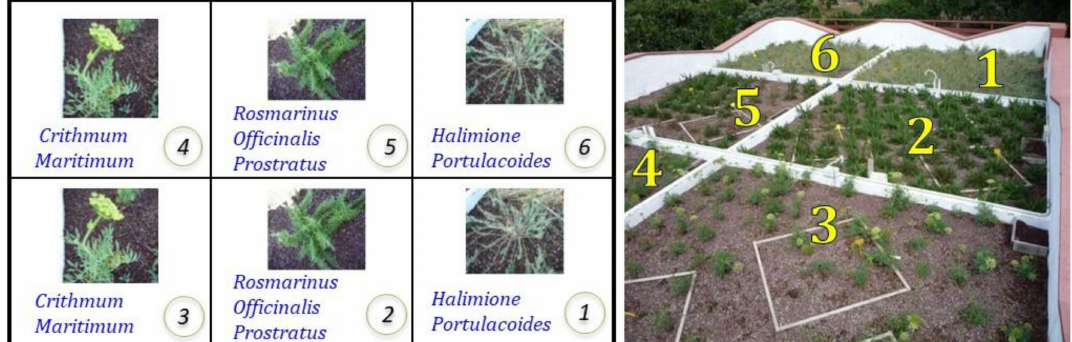
Figure 6. Scheme of the plant species planted in the di ff erent sectors.